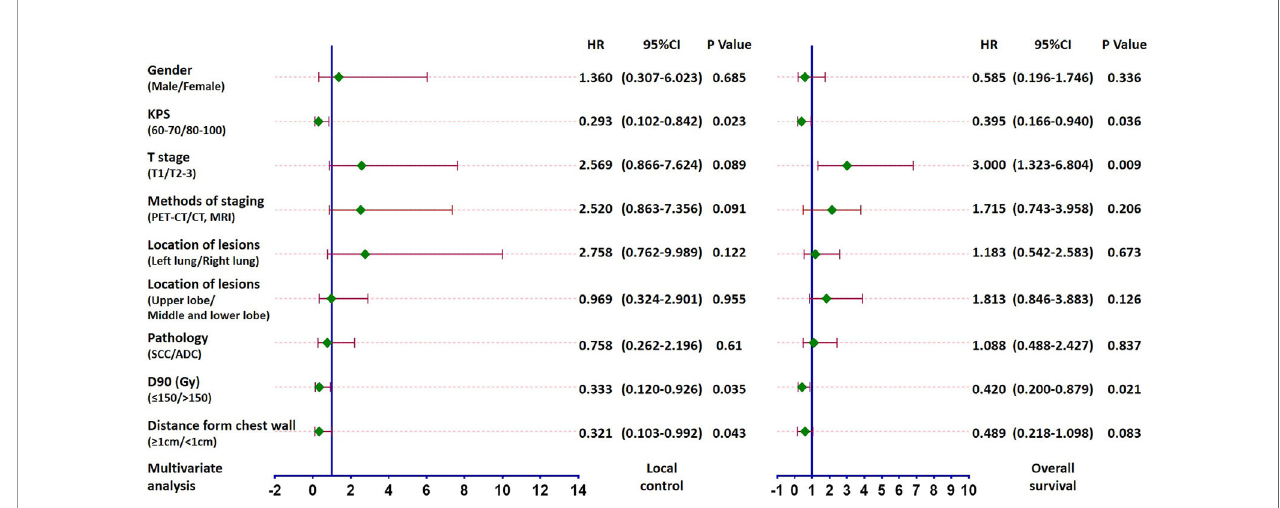
FIGURE 3 | Forest plot based on multivariate analysis of local control and survival: KPS score, GTV D90, and distance between the lesion and chest wall were independent factors for local control and KPS score, T stage and GTV D90 were independent factors for survival (all P <